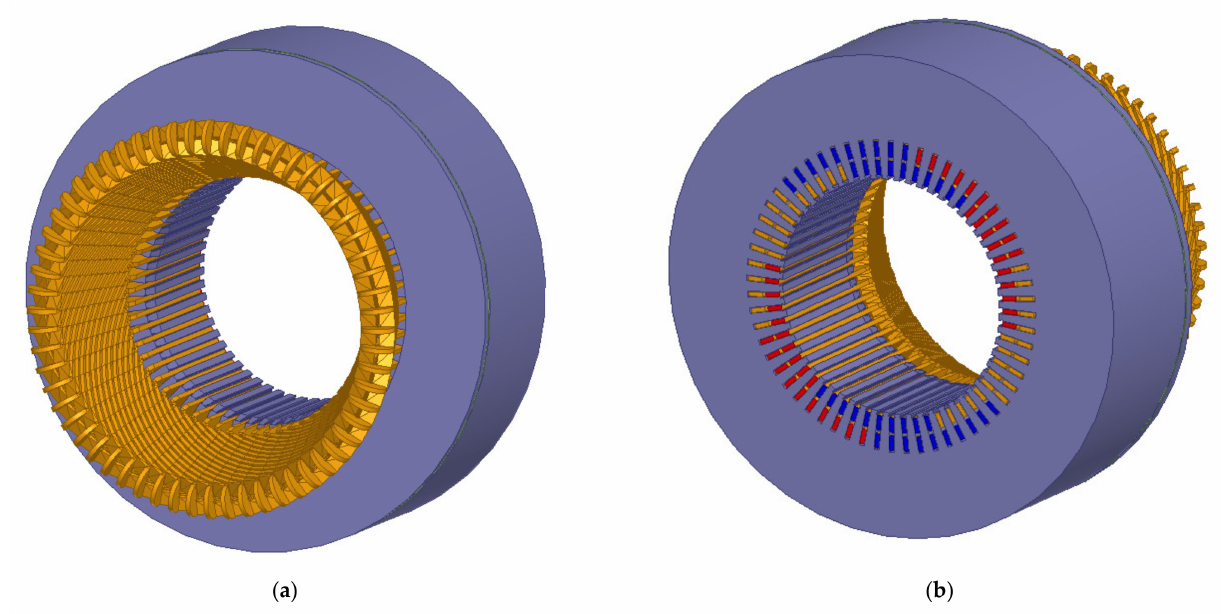
Figure 1. Three-dimensional model of a synchronous generator ( a , b ).